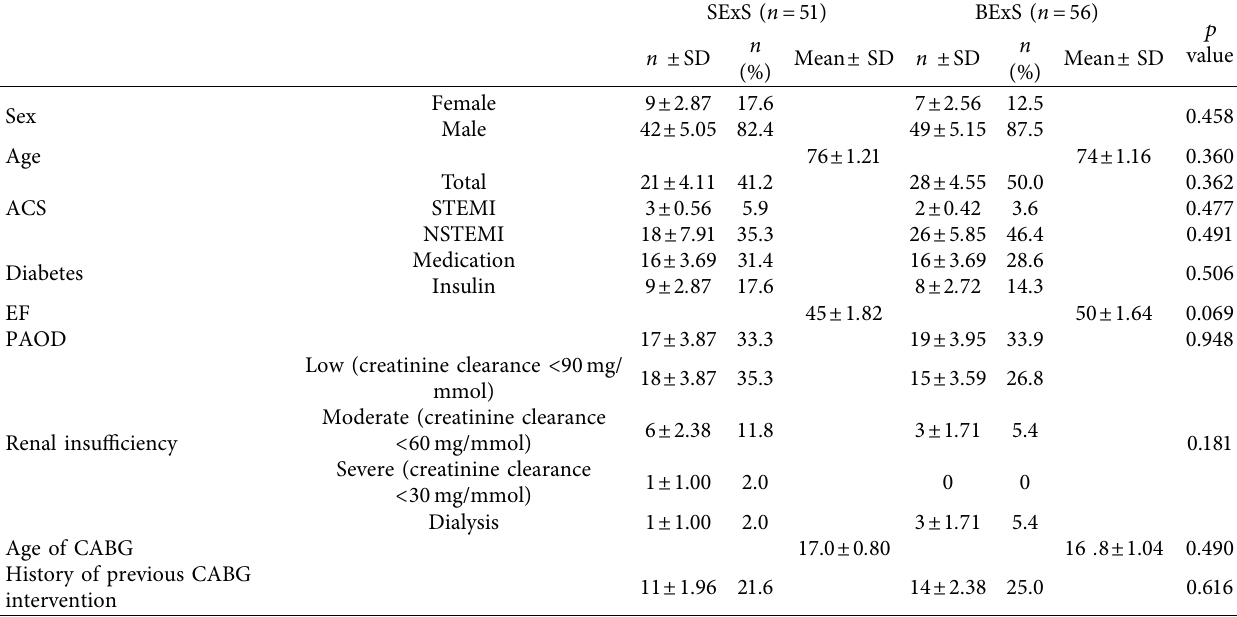
Figure 3: Retrospective data analysis. SVG � saphenous vein graft; SExS � self-expanding drug eluting stent; BExS � balloon expanding drug eluting stent; BMS � bare metal stent; DEB � drug eluting balloon; and POBA � plane old balloon Table 1: Patient characteristics.